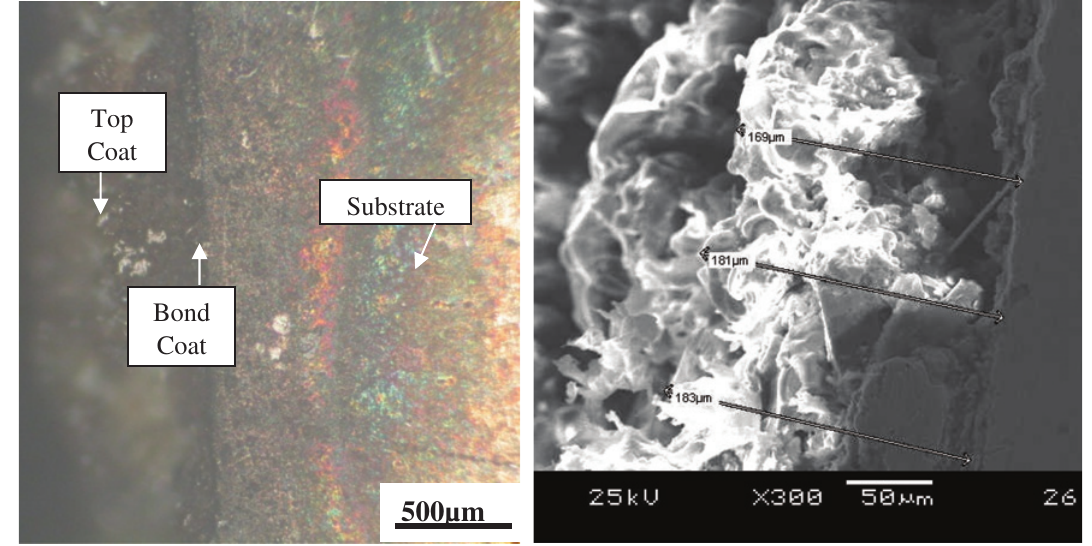
Figure 5: Thermal cycled at 50th